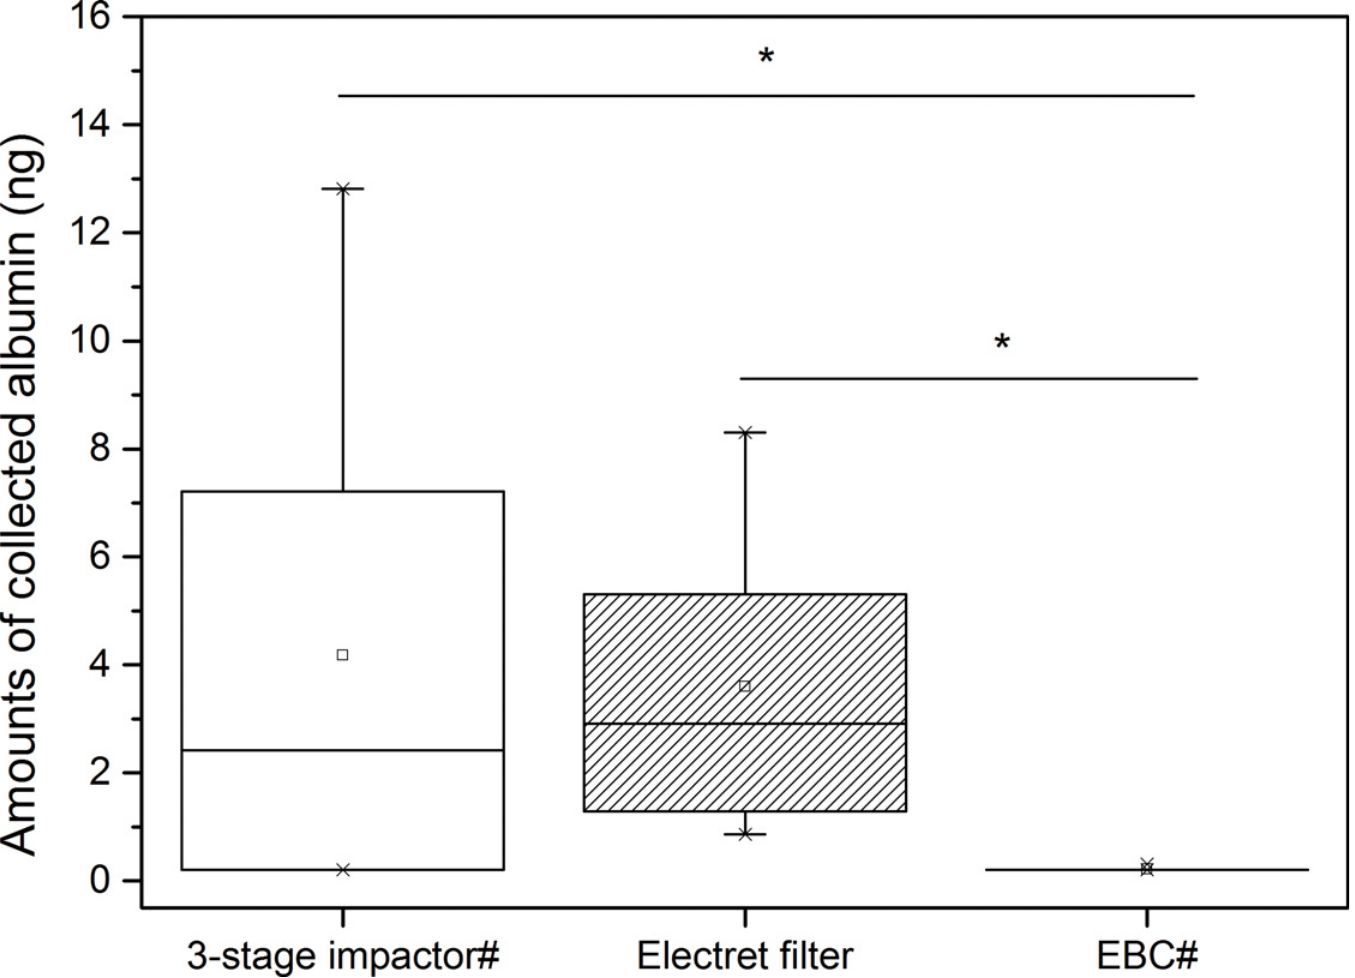
Fig 6. Comparison of collecting ability of 3 different collecting methods. * indicates significance at p < 0.05. # indicates boxplot was drawn by the author from data in [22].